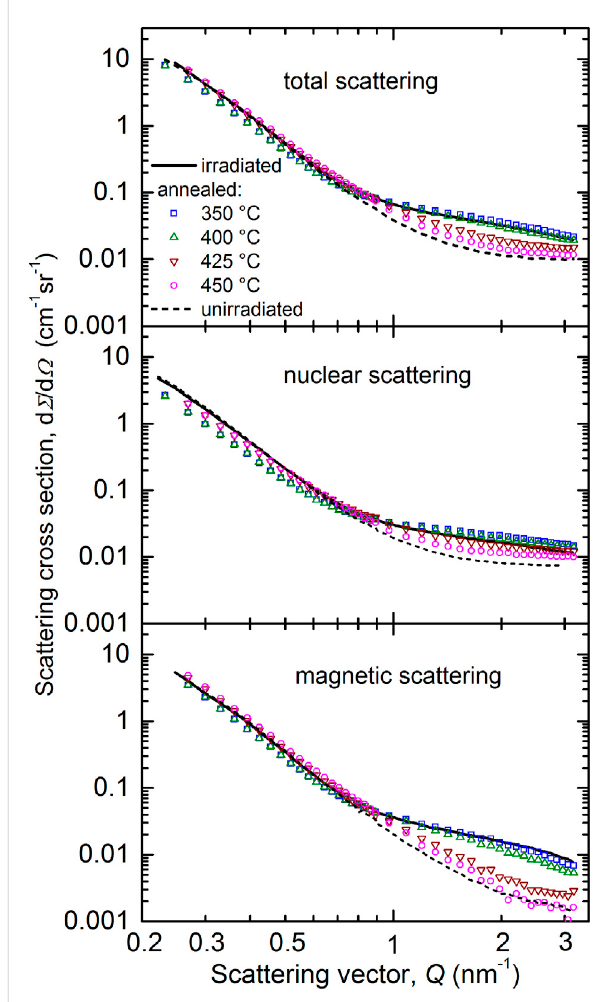
FIGURE 2 Measured total (upper plot), nuclear (center plot) and magnetic (lower plot) scattering cross sections for the unirradiated reference, the as-irradiated condition and the post-irradiation annealed condition (475 ° C) of the weld material.